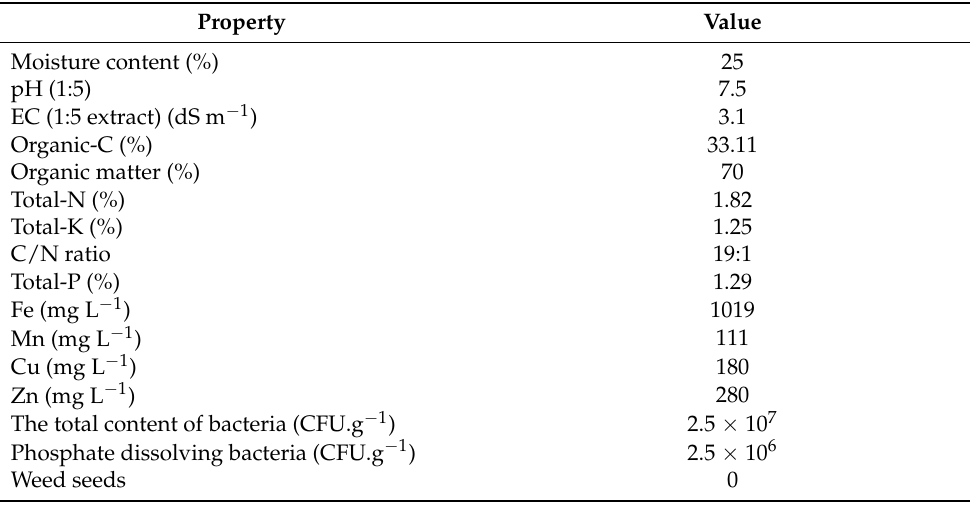
Table 2. Chemical properties of applied organic matter